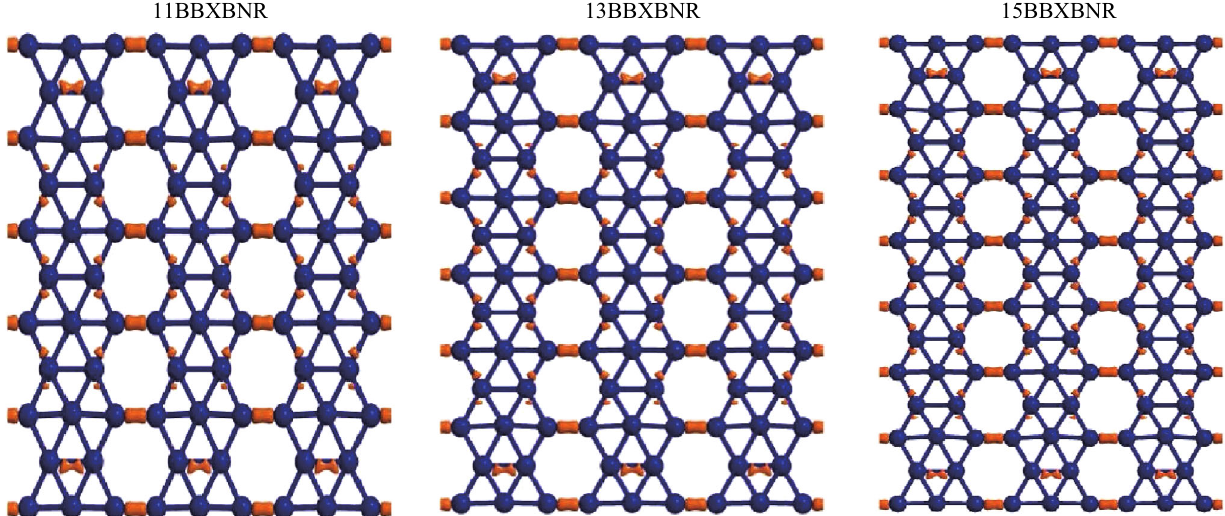
Fig. 4 Electron density of 11BBXBNR , 13BBXBNR , and